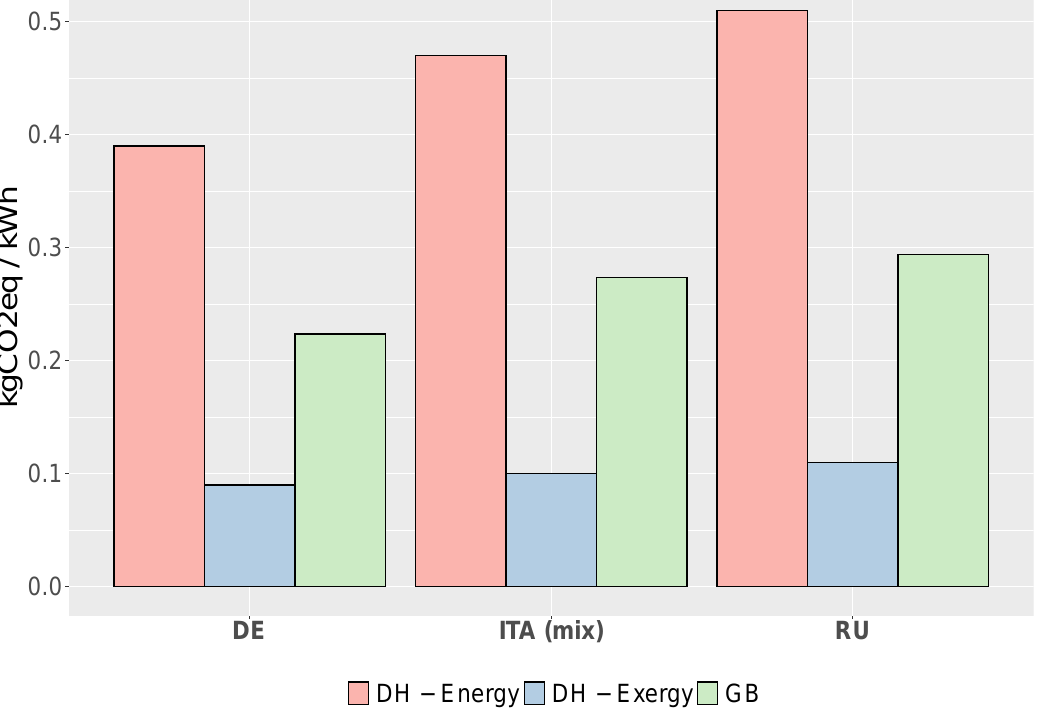
Figure 4. DH specific impact with different gas